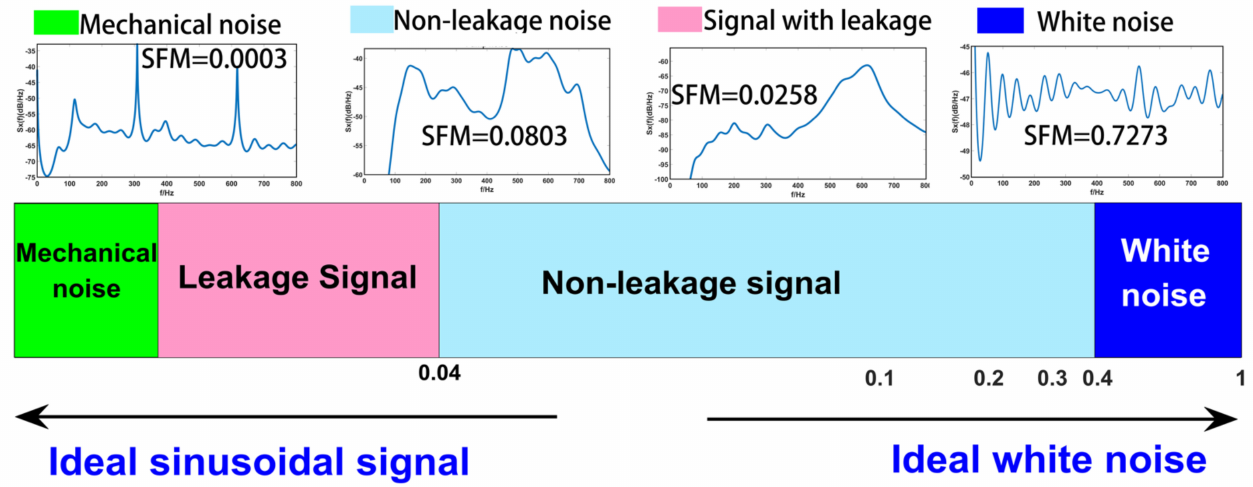
Figure 3. Classification standard for the spectral flatness of leakage detection.